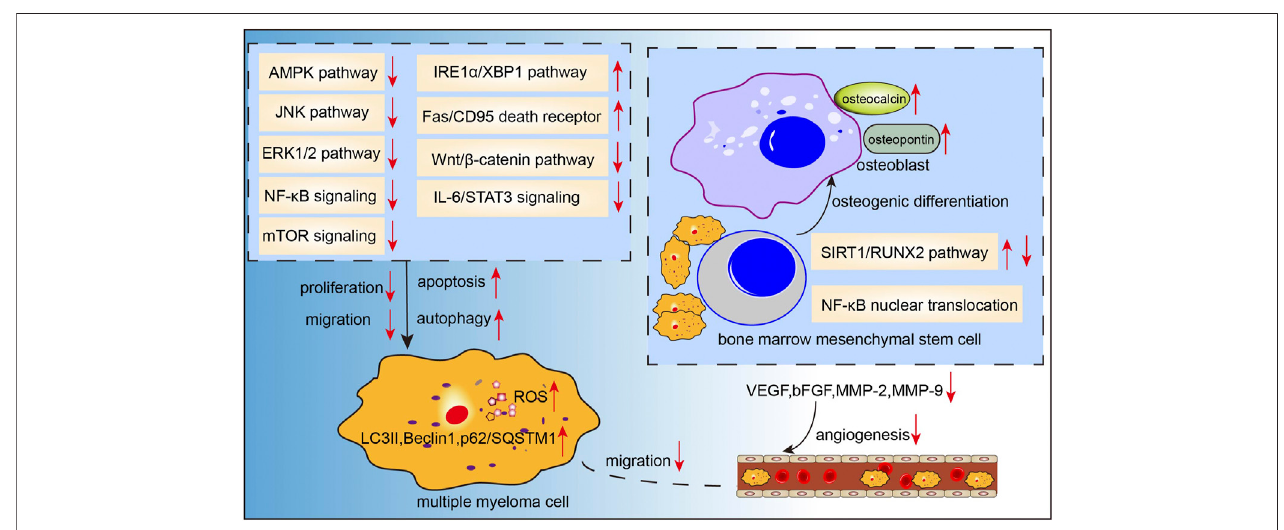
FIGURE 4 | Action pathways involved in the anti-MM effects of